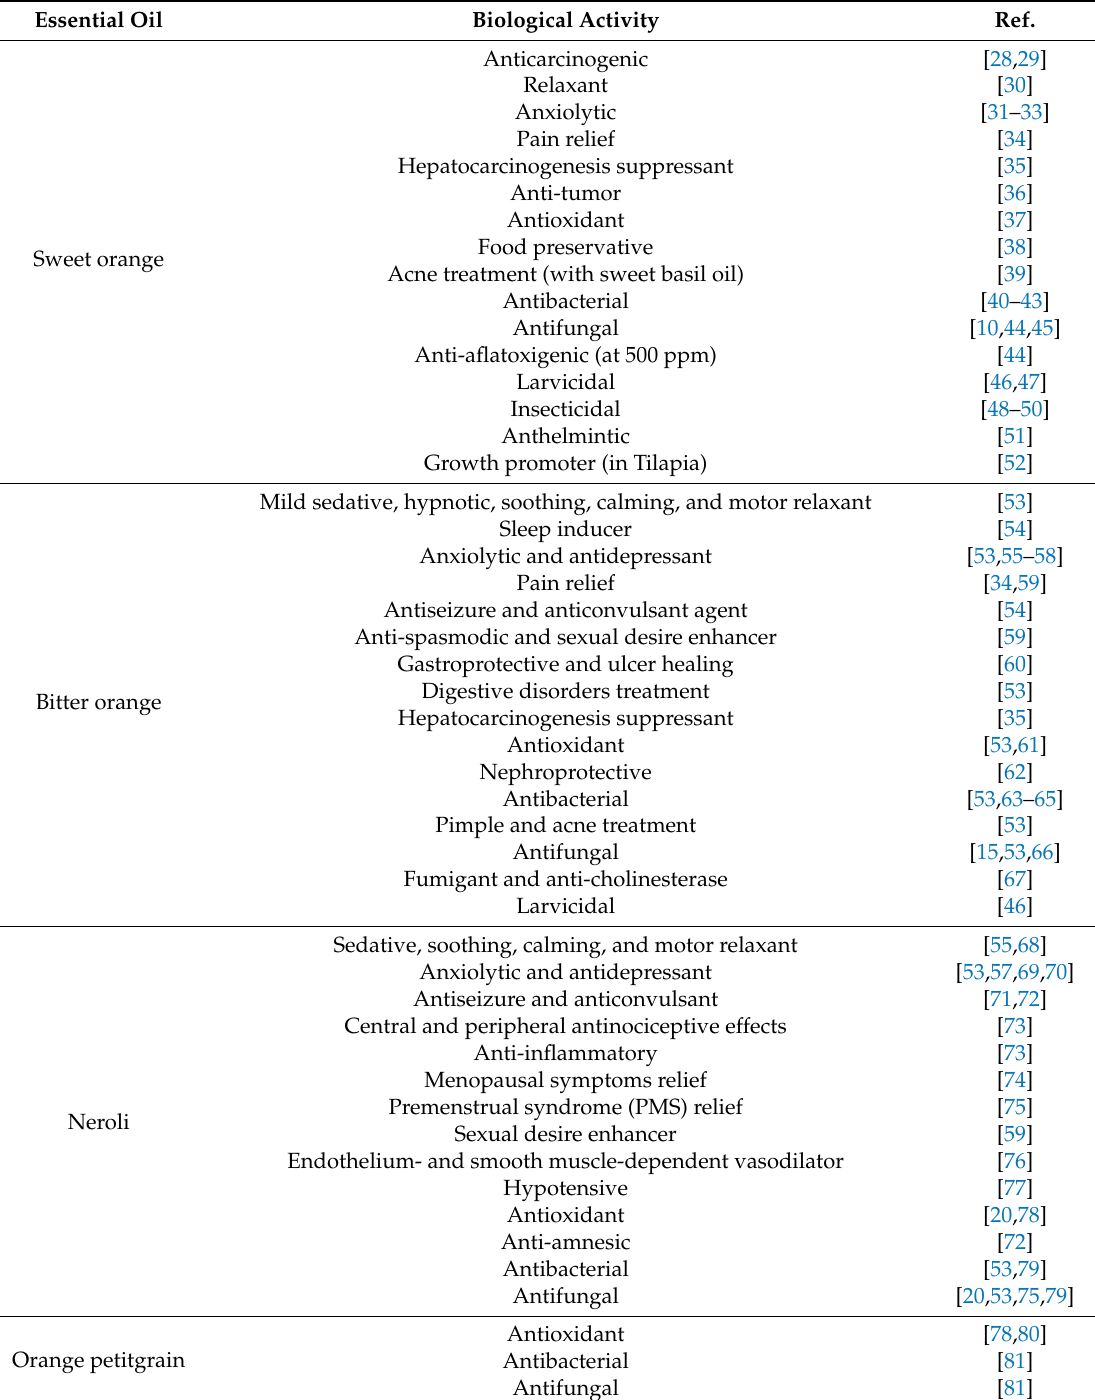
Table 3. Biological activities of different Citrus essential